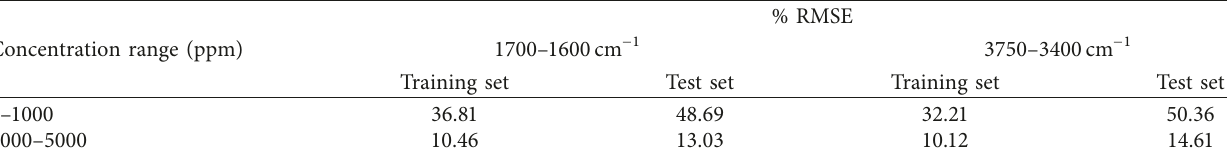
Table 2: Average % RMSE for subsets of low and high moisture concentrations in lubricating oil according to spectral regions at 3750–3400 and 1700–1600cm